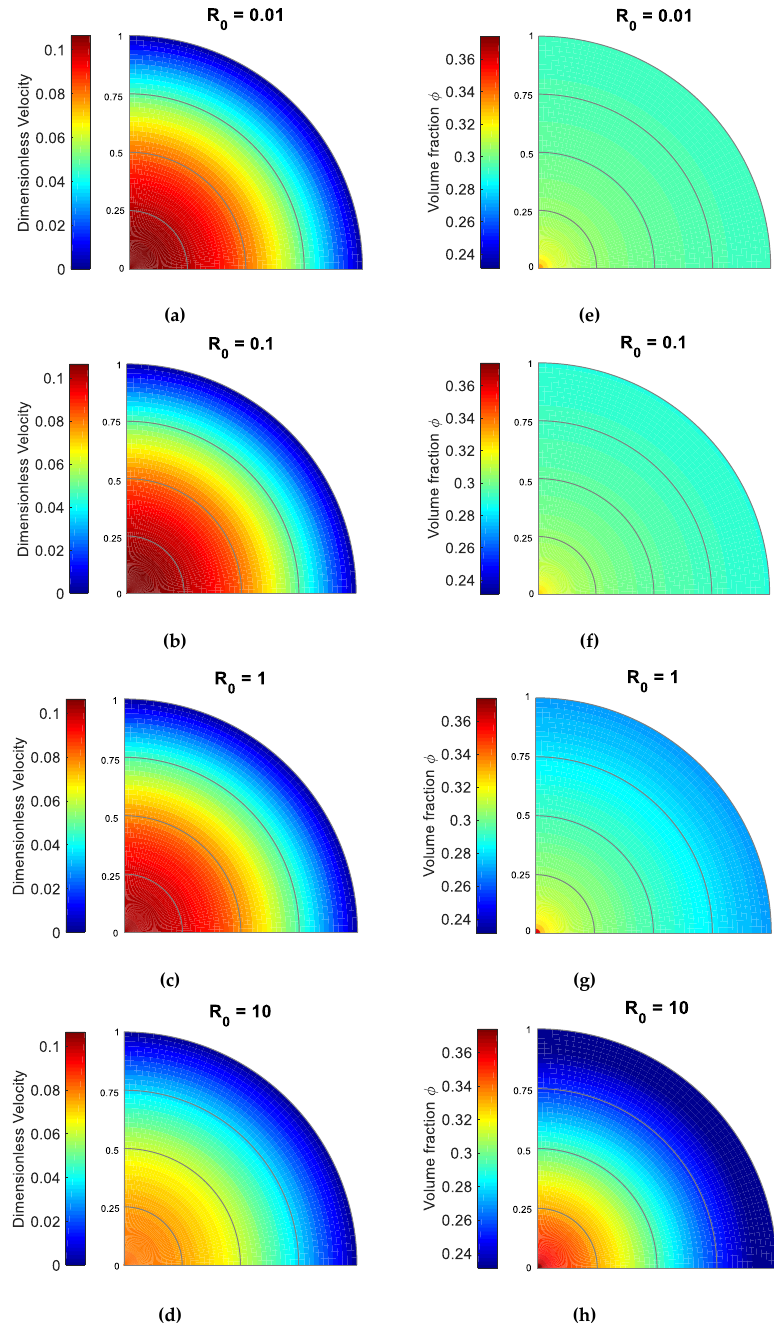
Figure 11. Distribution of the velocity for ( a ) R 0 = 0.01; ( b ) R 0 = 0.1; ( c ) R 0 = 1; ( d ) R 0 = 10; and the cement volume concentration for ( e ) R 0 = 0.01 ; ( f ) R 0 = 0.1; ( g ) R 0 = 1; ( h ) R 0 = 10.